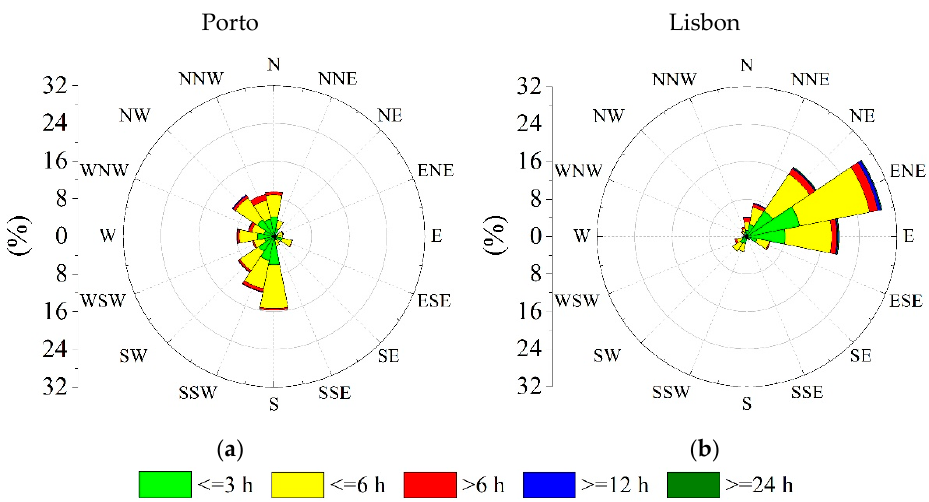
Figure 6. Relative frequency wind roses of the fog events duration at Lisbon ( a ) and Porto ( b ) airports.